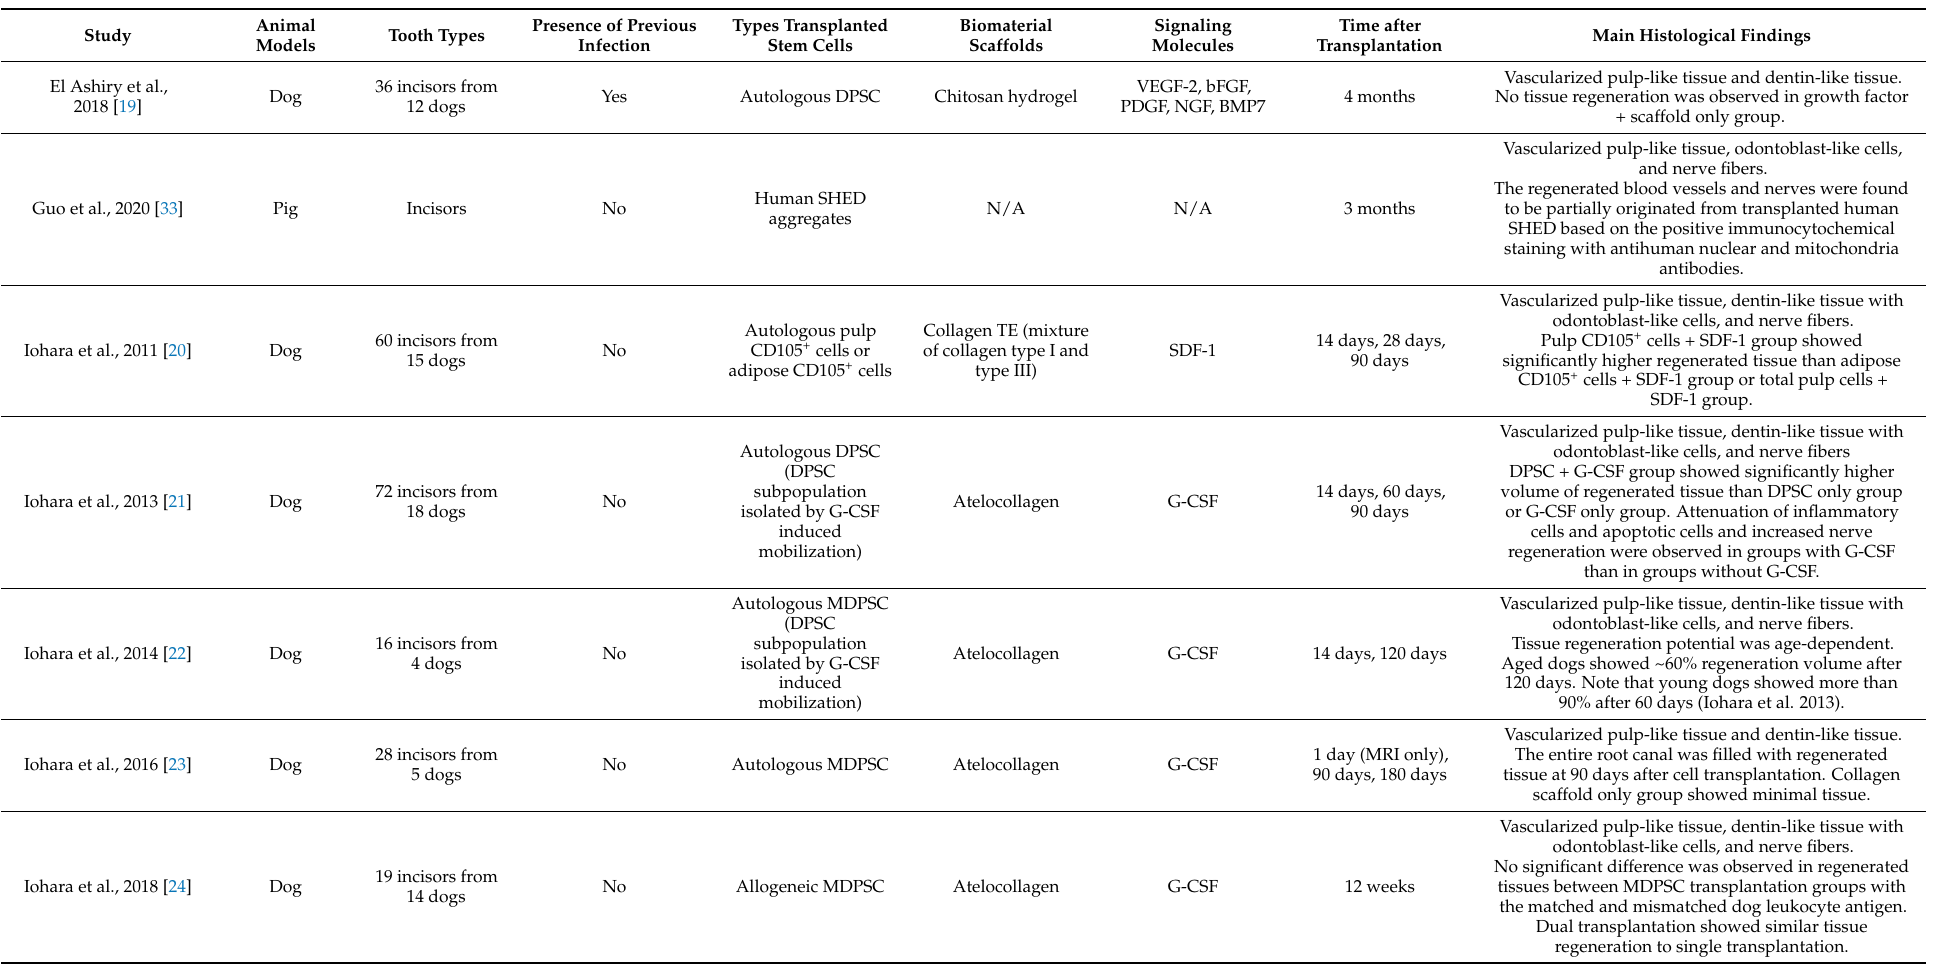
Table 1. Summary of the characteristics of the included animal